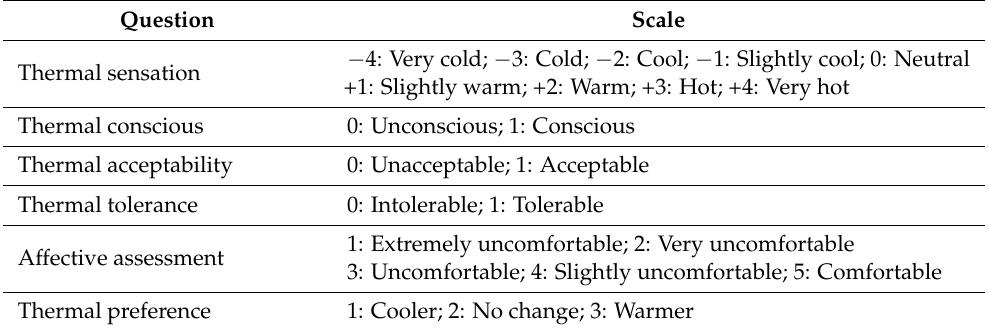
Table 2. Subjective vote